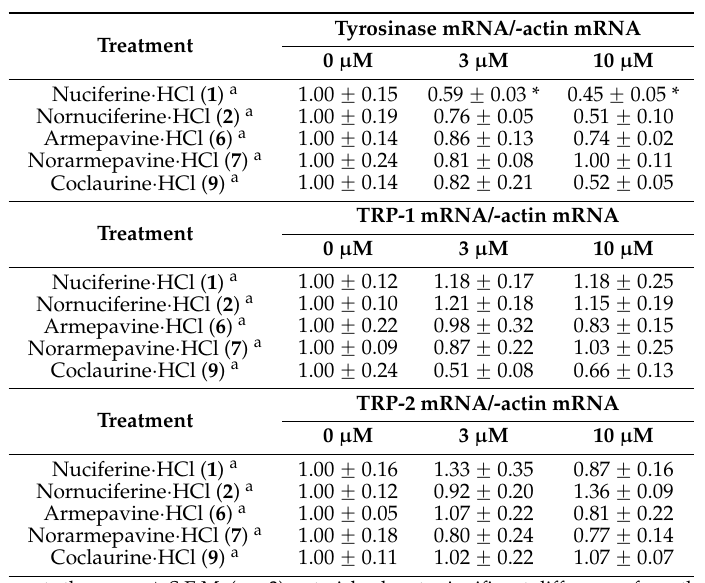
Table 9. Effects of 1 , 2 , 6 , 7 , and 9 on expression of tyrosinase, TRP-1, and TRP-2 mRNA in B16 4A5